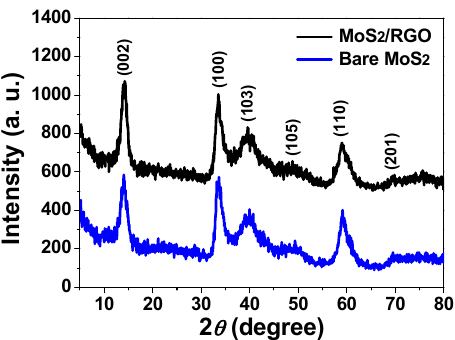
Figure 4. XRD patterns of MoS 2 /RGO hollow microspheres (black curve) and bare MoS 2 microspheres (blue curve).